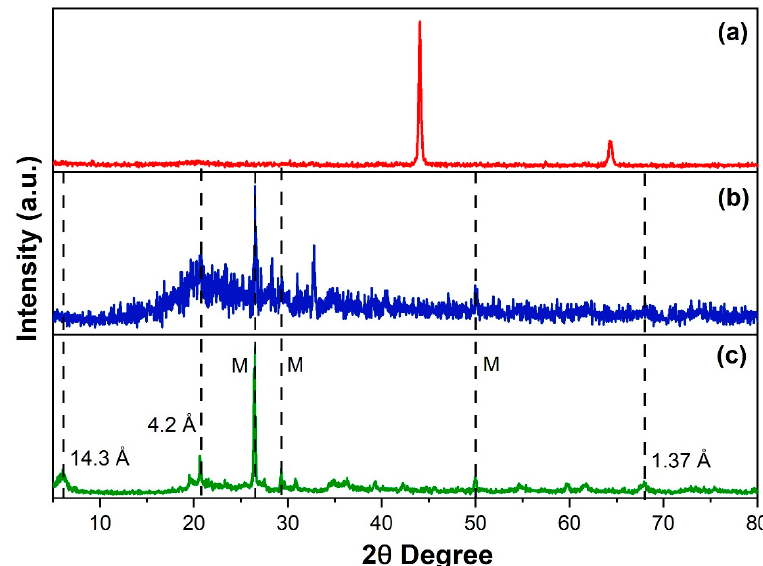
Figure 6. XRD results of: ( a ) Phenol-furfural resin; ( b ) Phenol-furfural resin/organo modified MMT clay composite; ( c ) Organo modified MMT clay.